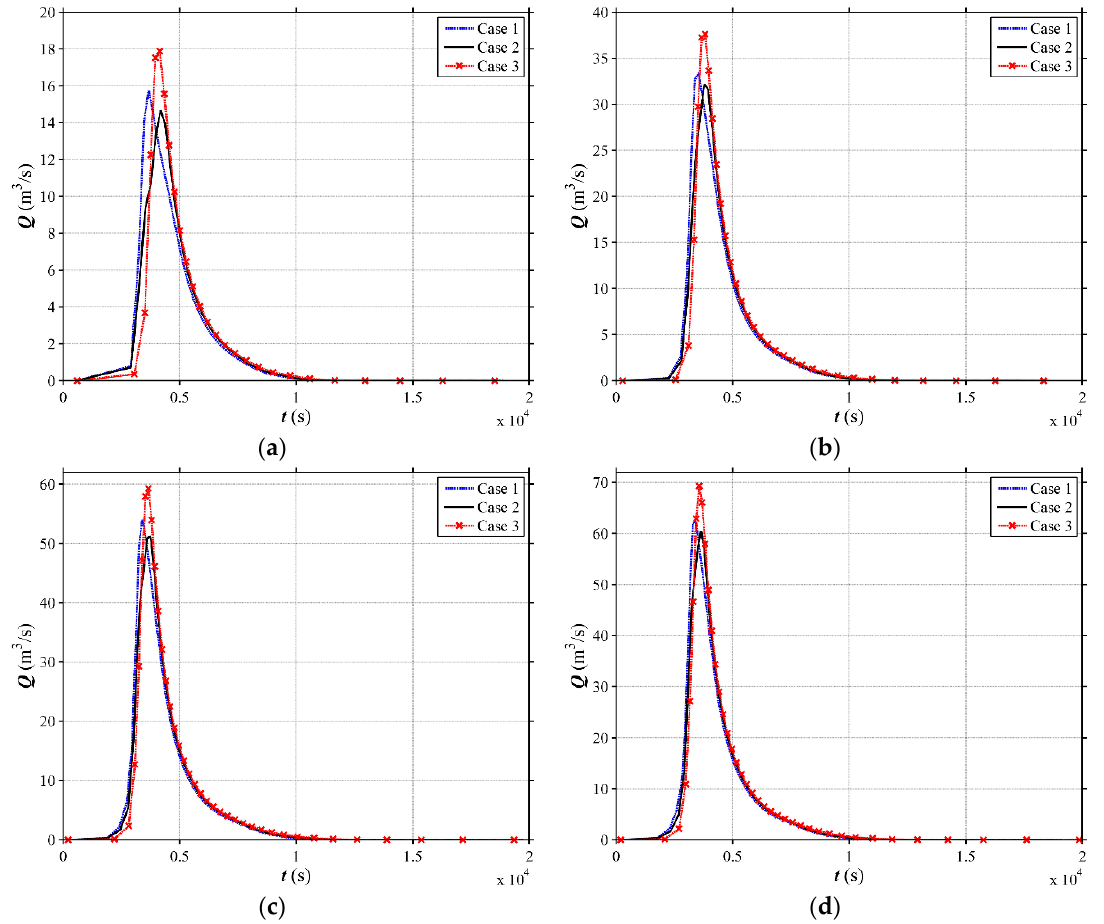
Figure 5. Simulated hydrographs at the outlet for different land use scenarios in the V-shaped catchment with i 1 = 0.01. ( a ) 2-year; ( b ) 10-year; ( c ) 50-year; ( d ) 100-year.